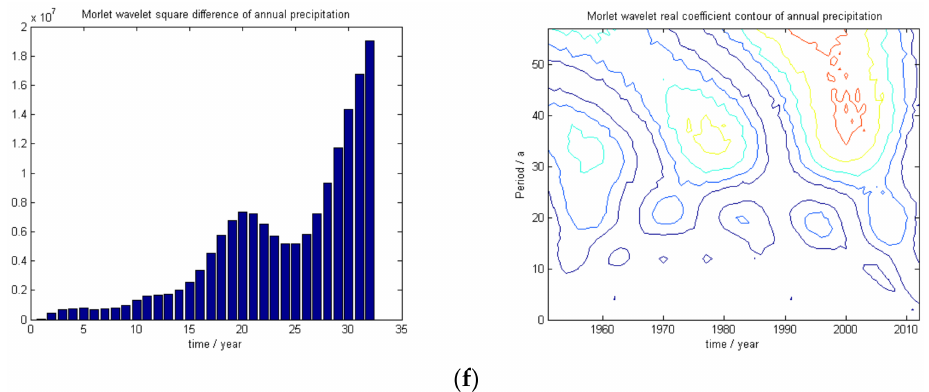
Figure 3. Wavelet analysis of annual precipitation at six representative precipitation observation stations in China. ( a ) Wavelet analysis of annual precipitation at Baishan; ( b ) Wavelet analysis of annual precipitation at Harbin; ( c ) Wavelet analysis of annual precipitation at Zhengzhou; ( d ) Wavelet analysis of annual precipitation at Guangzhou; ( e ) Wavelet analysis of annual precipitation at Kunming; ( f ) Wavelet analysis of annual precipitation at Urumqi.